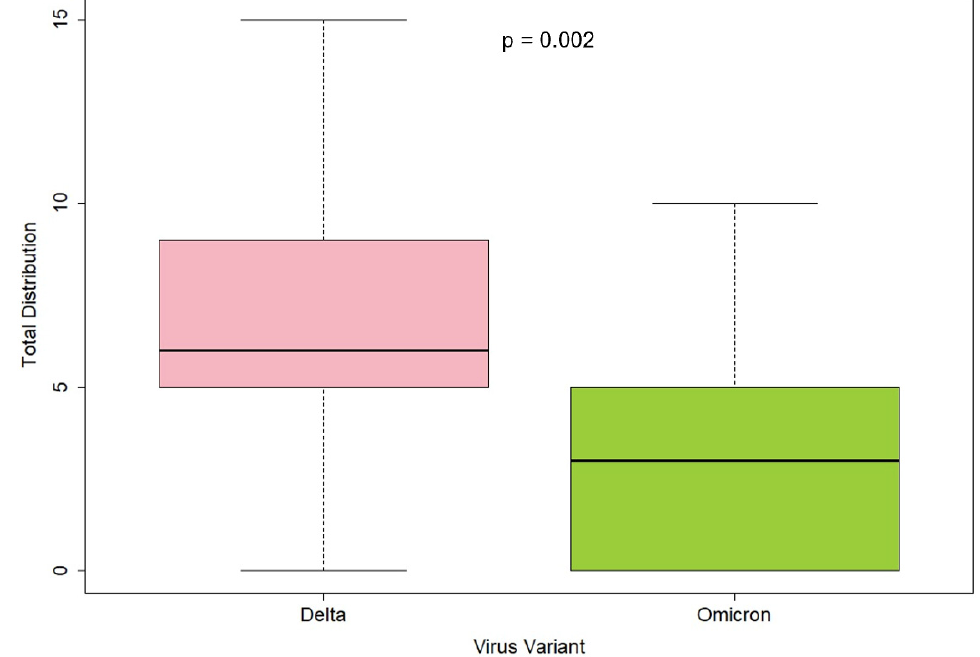
Figure 3. Box and whisker plot. Semiquantitative total distribution according to virus variant. p = 0.002 from t -test. Table 5. Multiple regression analysis of semiquantitative lung involvement and virus variant, ad- justed for vaccination status and stage of infection. Predictor Estimate ( β ) 95%CI p -Value Model 1: Association of semiquantitative lung involvement and virus variant, adjusted for vaccination